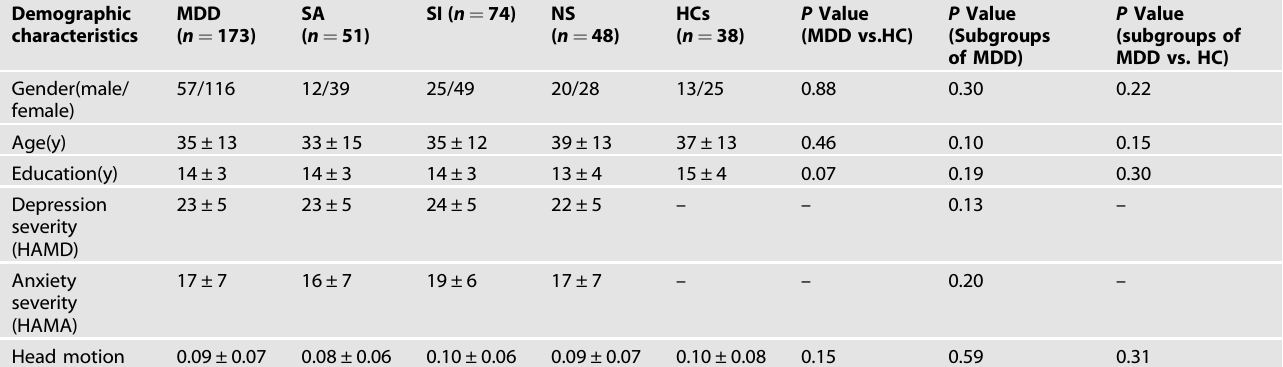
Table 1. Demographic and clinical characteristics of HCs and MDD with different suicide risks. Demographic characteristics